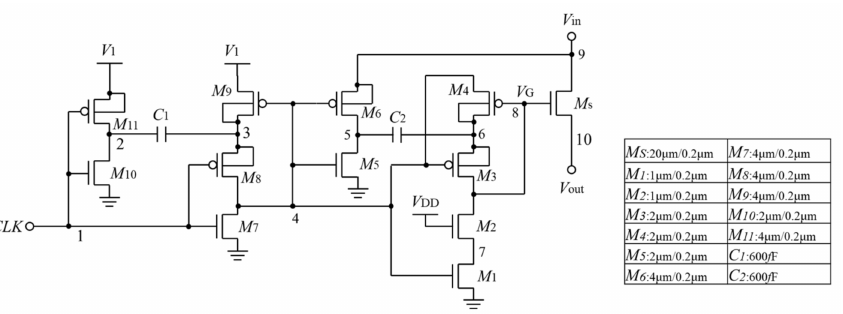
Figure 1. The bootstrapped switch in [17] and the designed size of elements. When the bootstrapped switch is in the “ON” phase, the CLK is “ 1 ”. Then, the voltage of Node 4 is pulled down to GND via M 7 and the voltage of Node 2 is pulled down